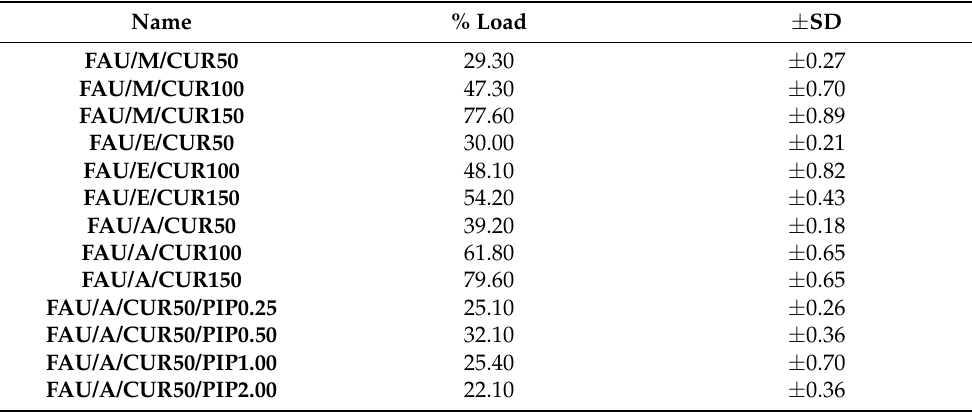
Table 4. Curcumin loading into commercial FAU-type zeolite.